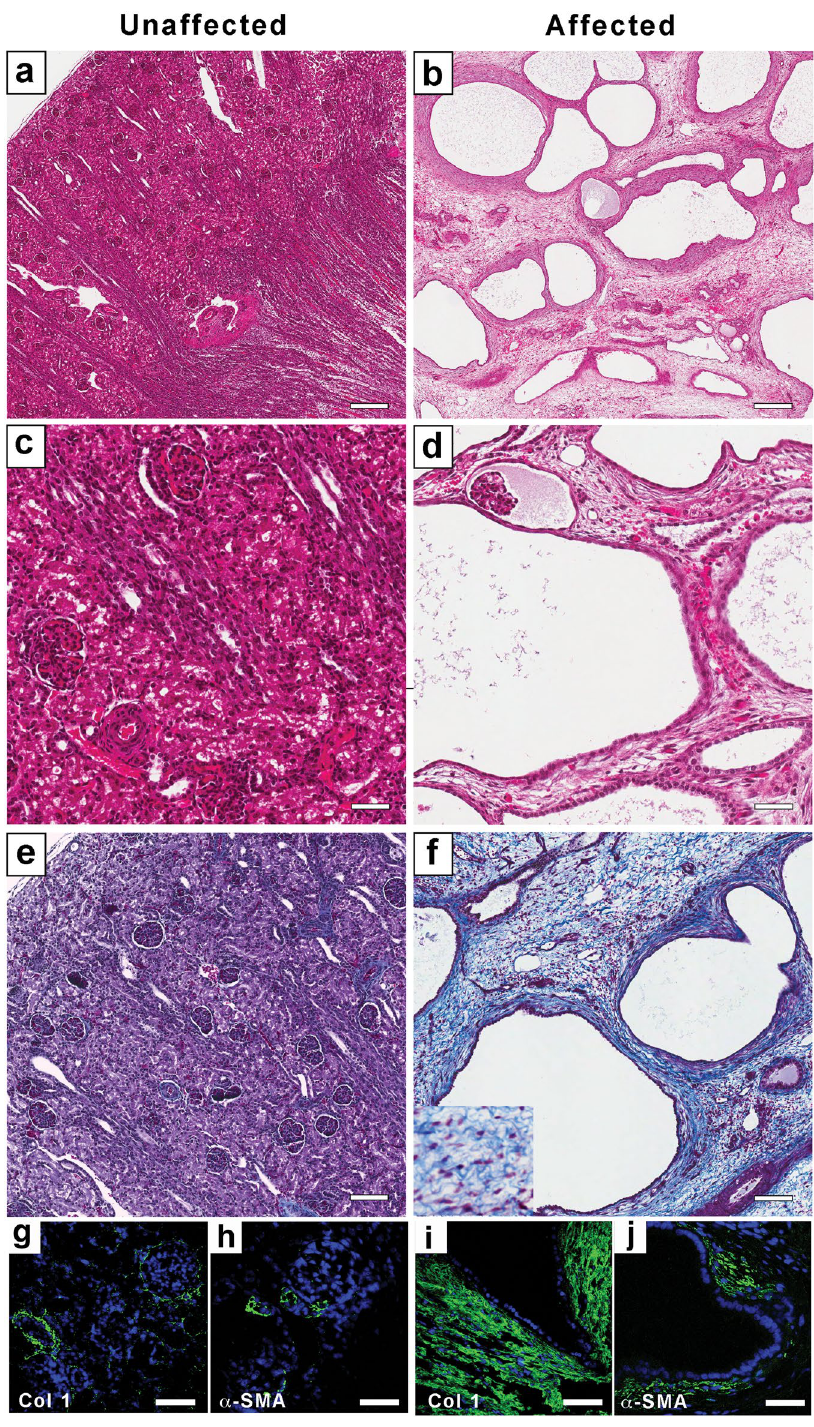
Figure 1. Renal fibrocystic dysplasia in affected lambs. H&E stained tissue sections at lower ( a , b ) and higher ( c , d ) magnification showing kidney architecture of an unaffected newborn lamb ( a and c ), compared to kidney of an affected newborn lamb, with multiple, fluid-filled cysts (1–5 mm diameter) evident throughout the cortex and medulla ( b and d ). Masson’s Trichrome stained sections of unaffected ( e ), and affected ( f ) kidneys. The extensive fibrosis present in the affected kidney ( f -inset) shows thick collagen fibres (stained blue) within the interstitium. ( g–i ) Immunohistochemistry using collagen type I (green; g , i ), and α -smooth muscle actin antibodies (green; h , j ) on unaffected ( g , h ) and affected ( i , j ) kidneys, respectively. Nuclei (blue) are stained with DAPI. Scale bars: a, b = 200 μ m; c, d, e, f = 100 μ m. g, h, i, j = 50 μ